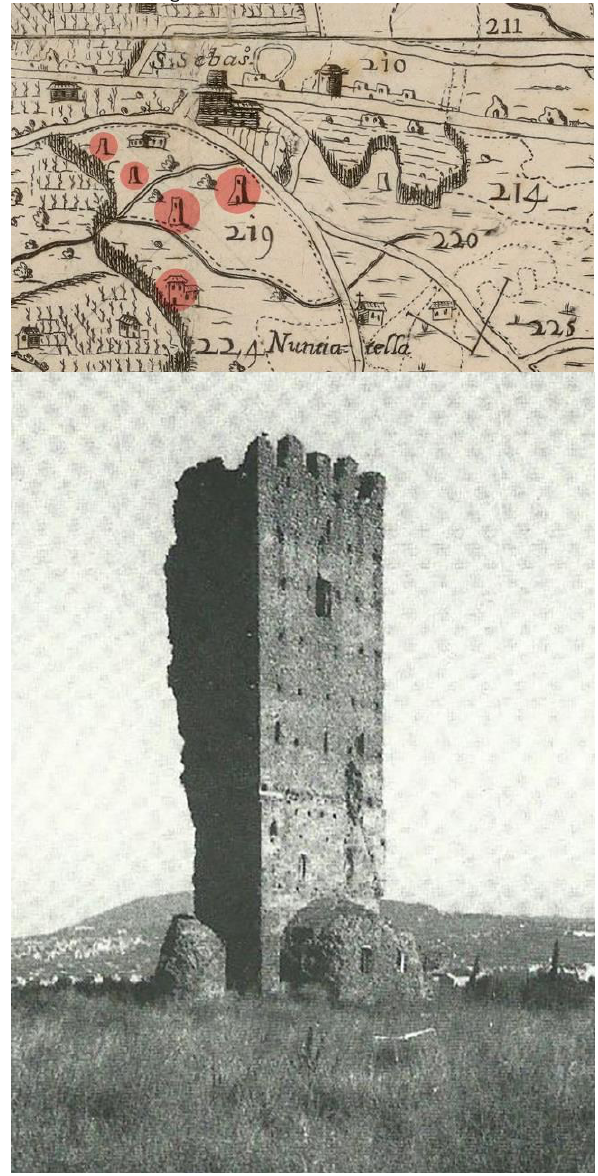
Figure 2. Planimetry of Giovanni Battista Cingolani della Pergola (1692) with identification of the Cinque Torri estate, the old name of Capo di Bove and of the respective defensive towers inside it. Below, Zampa di Bove, the last of the five towers, collapsed in 1985, due to the lack of maintenance interventions adequate for